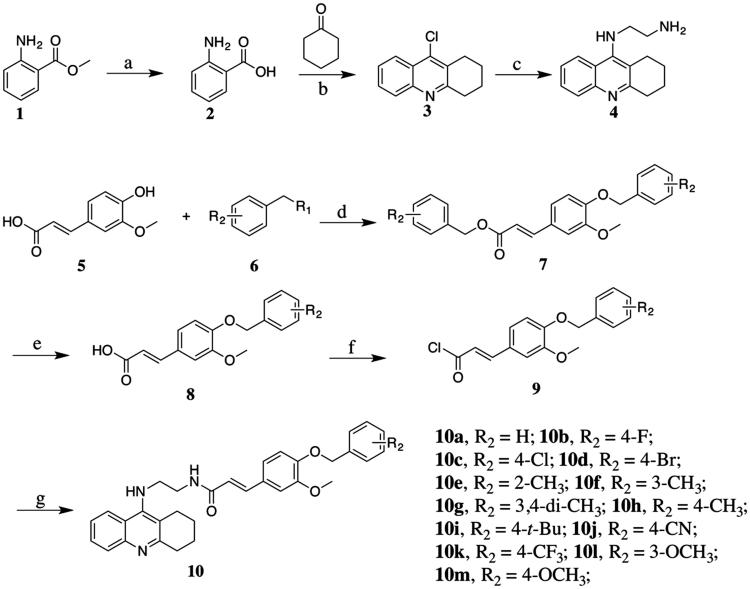
Reagents and conditions: (a) NaOH, H2O, room temperature (r.t), 12 h; (b) POCl3, reflux, 3 h; (c) 1-pentanol, ethylenediamine, 160 °C, 18 h; (d) K2CO3, DMF, 82 °C, 4 h; (e) NaOH, MeOH, H2O, 82 °C, 3 h; (f) SOCl2, CH2Cl2, reflux, 3 h; and (g) K2CO3, Na2SO4, CH2Cl2, r.t, 24 h.